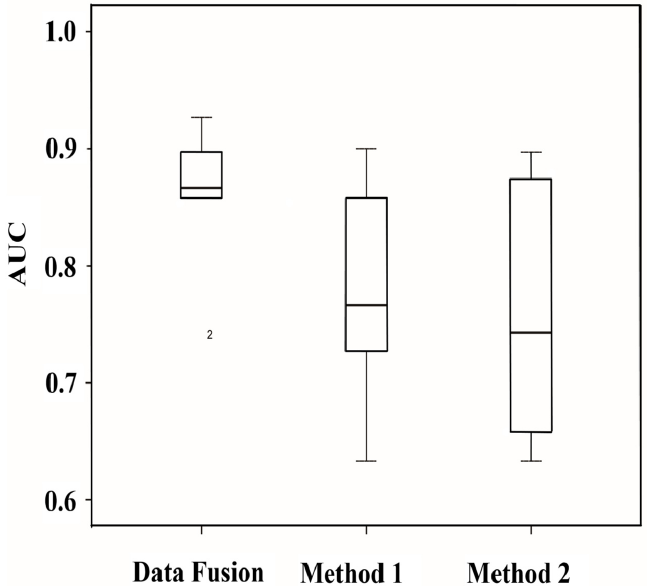
Figure 5. Boxplot of the average AUC of 6 different ARFs members studied herein before and after combination using specific features of ARF-binding. Data fusion method is a combination of method_1 and method_2. Method_1 represents the prediction using overrepresented motifs, and method_2 corresponds to the prediction based on linear discriminant analysis